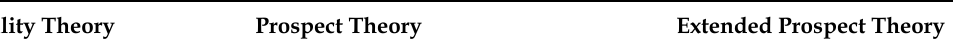
Table 2. Discriminating assumptions of UT, PT and